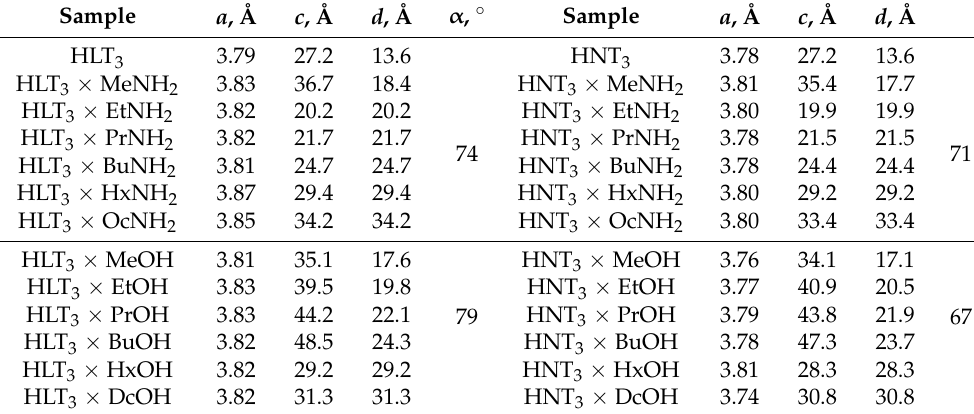
Table 1. Structural parameters of the initial titanates and their inorganic-organic derivatives as well as tilt angles of organic